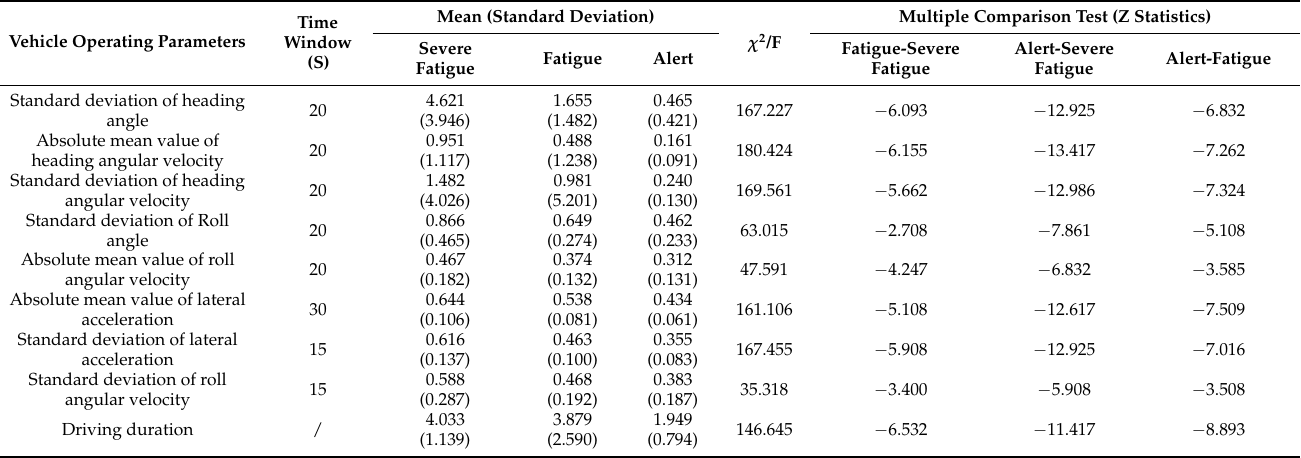
Table 2. Statistical analysis results of vehicle operating parameters (significantly affected) under different fatigue degrees. Vehicle Operating